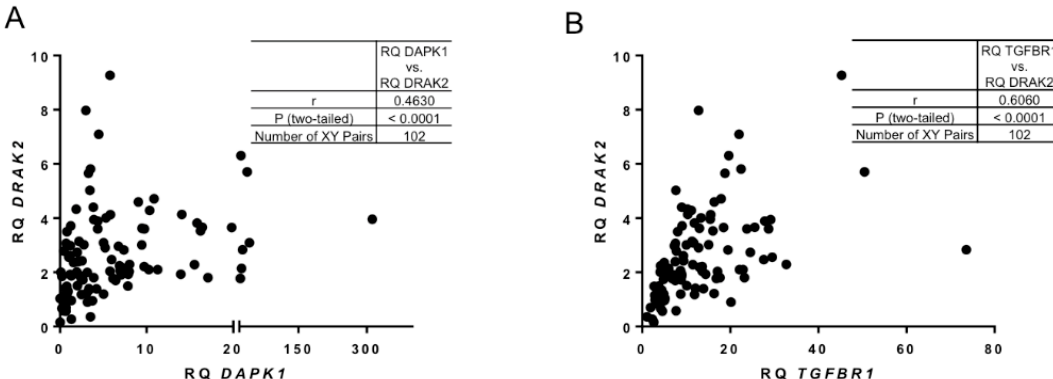
Figure 2. Correlation between DRAK2 and key targets of survival cellular pathways. Pearson’s correlation analysis showing strong, positive relationship between ( A ) DAPK1 and DRAK2 RNA expression and ( B ) TGFBR1 and DRAK2 RNA expression.